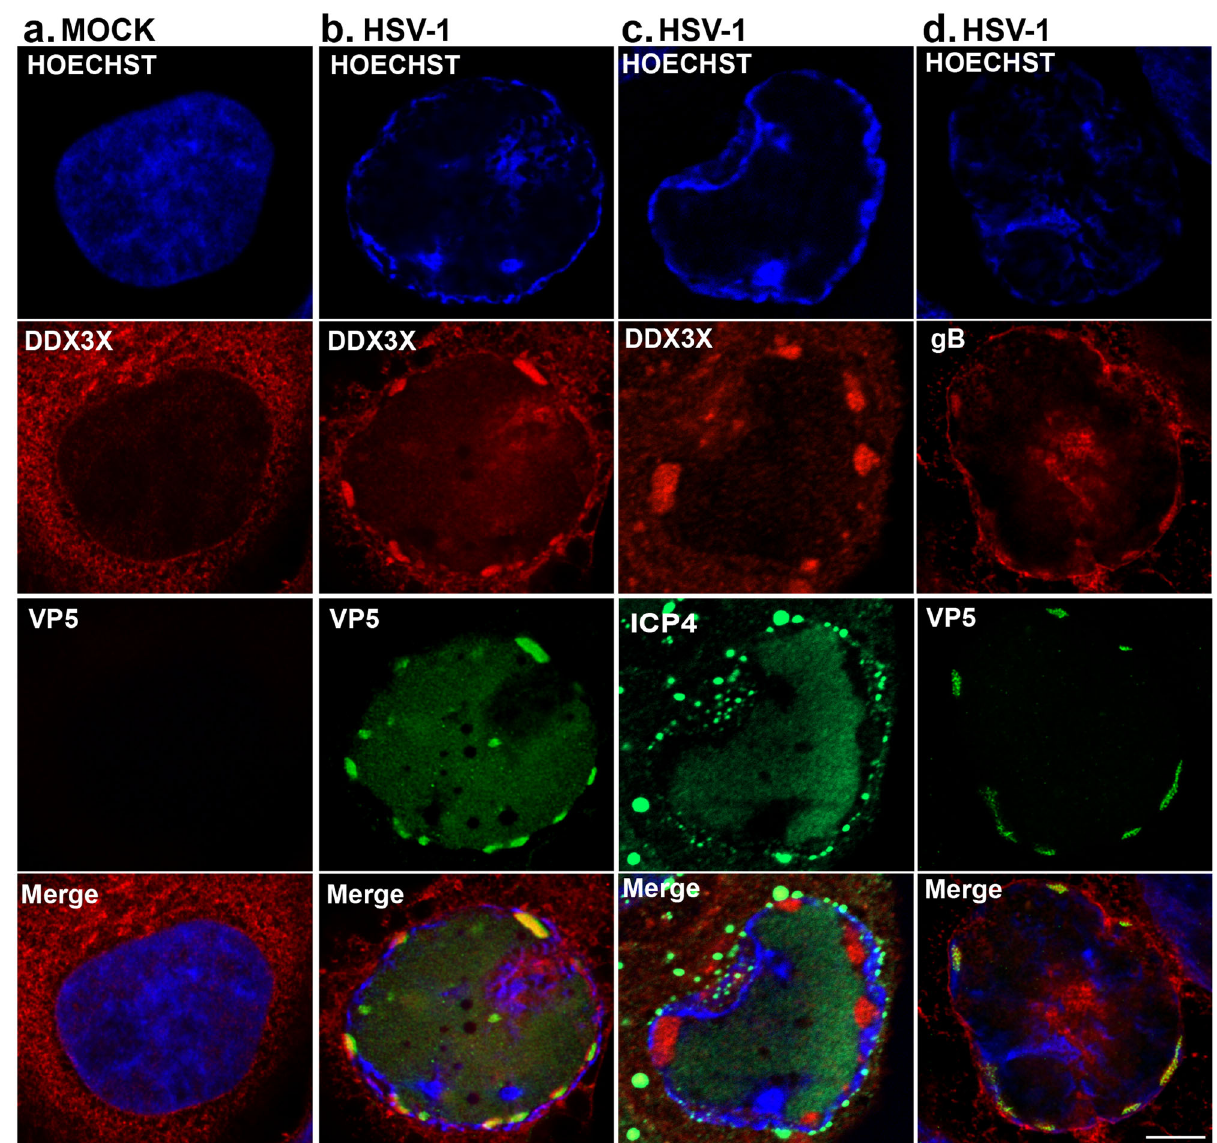
Fig. 4 DDX3X colocalises with large VP5 aggregates at the nuclear rim distinct from the viral replication compartments. HeLa cells seeded on coverslips were either a mock-treated or b – d infected wild-type strain 17 + virus at an MOI of 5 for 9 hpi. Cells were fi xed and labelled for a , b DDX3X (red) and VP5 (green) c DDX3X (red) and ICP4 (green) or d gB (red) and VP5 (green). All nuclei were stained with Hoechst 33342 (blue). Cells were imaged using dual colour high-resolution STED microscopy. Scale bar represents 5 µ m. The images are representative of three independent